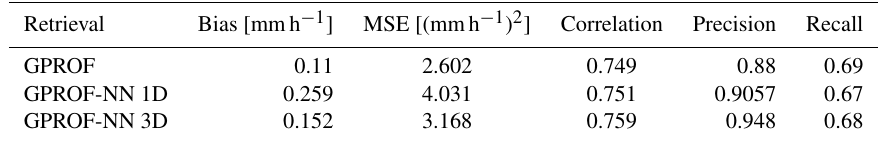
Table 8. Accuracy metrics for surface precipitation retrieved from MHS PMW observations of Hurricane Harvey for the overpass on 25 Au- gust 2017 at 13:58UTC. The metrics are calculated against the MRMS surface precipitationestimates.